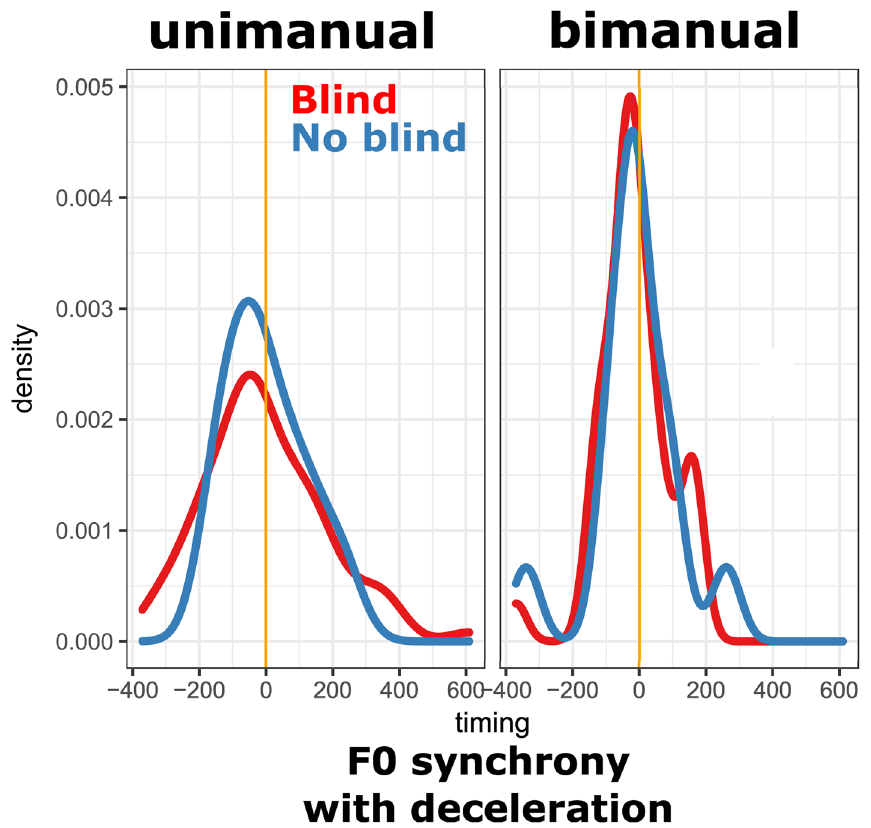
Figure 8. Peak deceleration and peak F0 timings. Note . The peak F0 versus peak deceleration timing distributions are shown, where more peaked distributions indicated more gesture-speech synchrony. It can be seen that there is a bimanual synchronization effect, suggestive of a role for physical